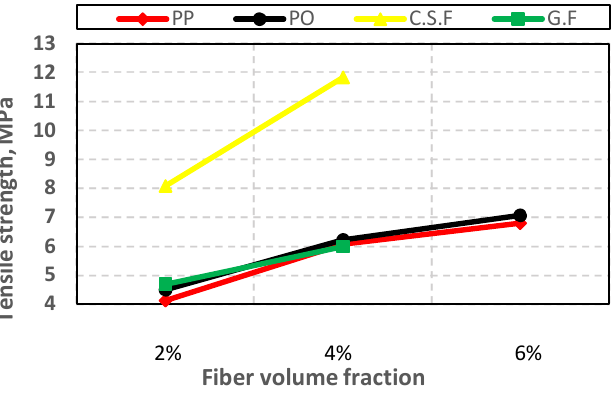
Figure 5. Splitting tensile strength of FRC and ECC.